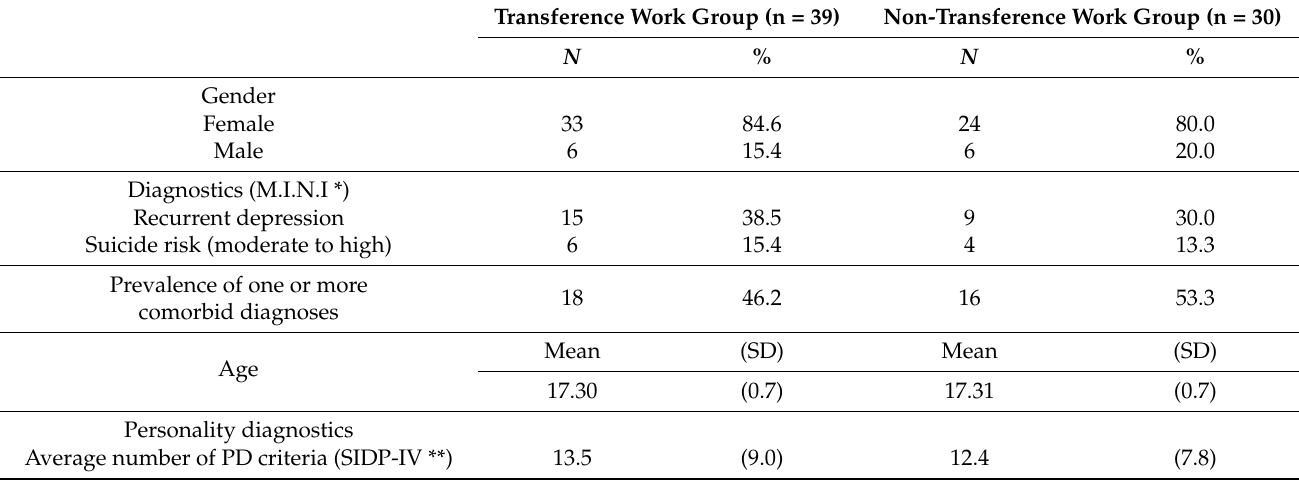
Table 1. Pre-treatment characteristics of adolescents in an RCT offering psychoanalytical psychotherapy [35]. Transference Work Group (n =